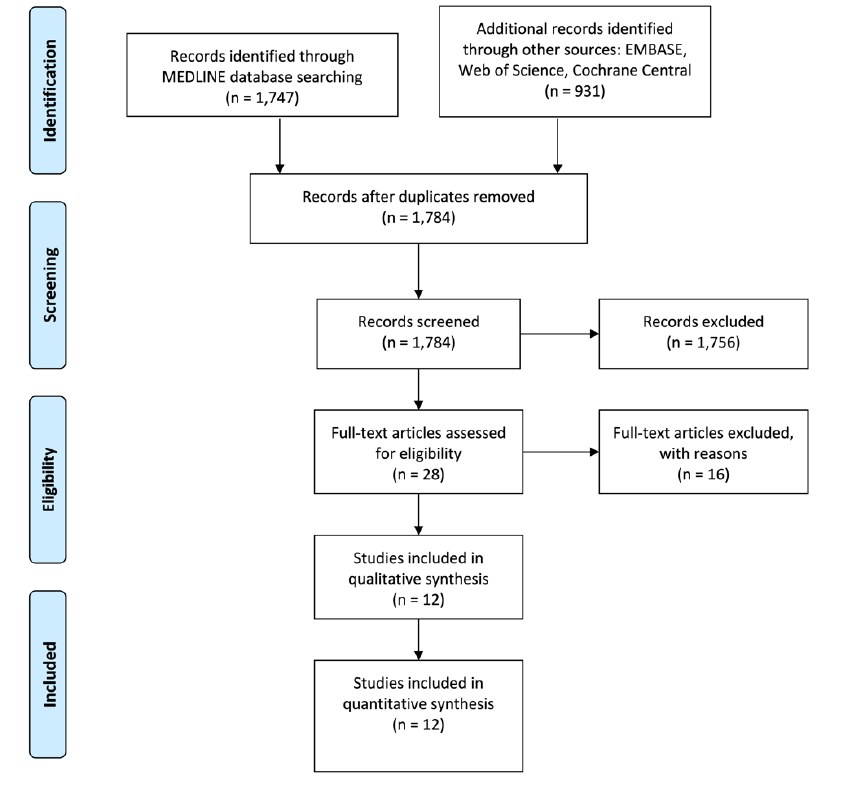
Figure 1. Flowchart illustrating the publication selection